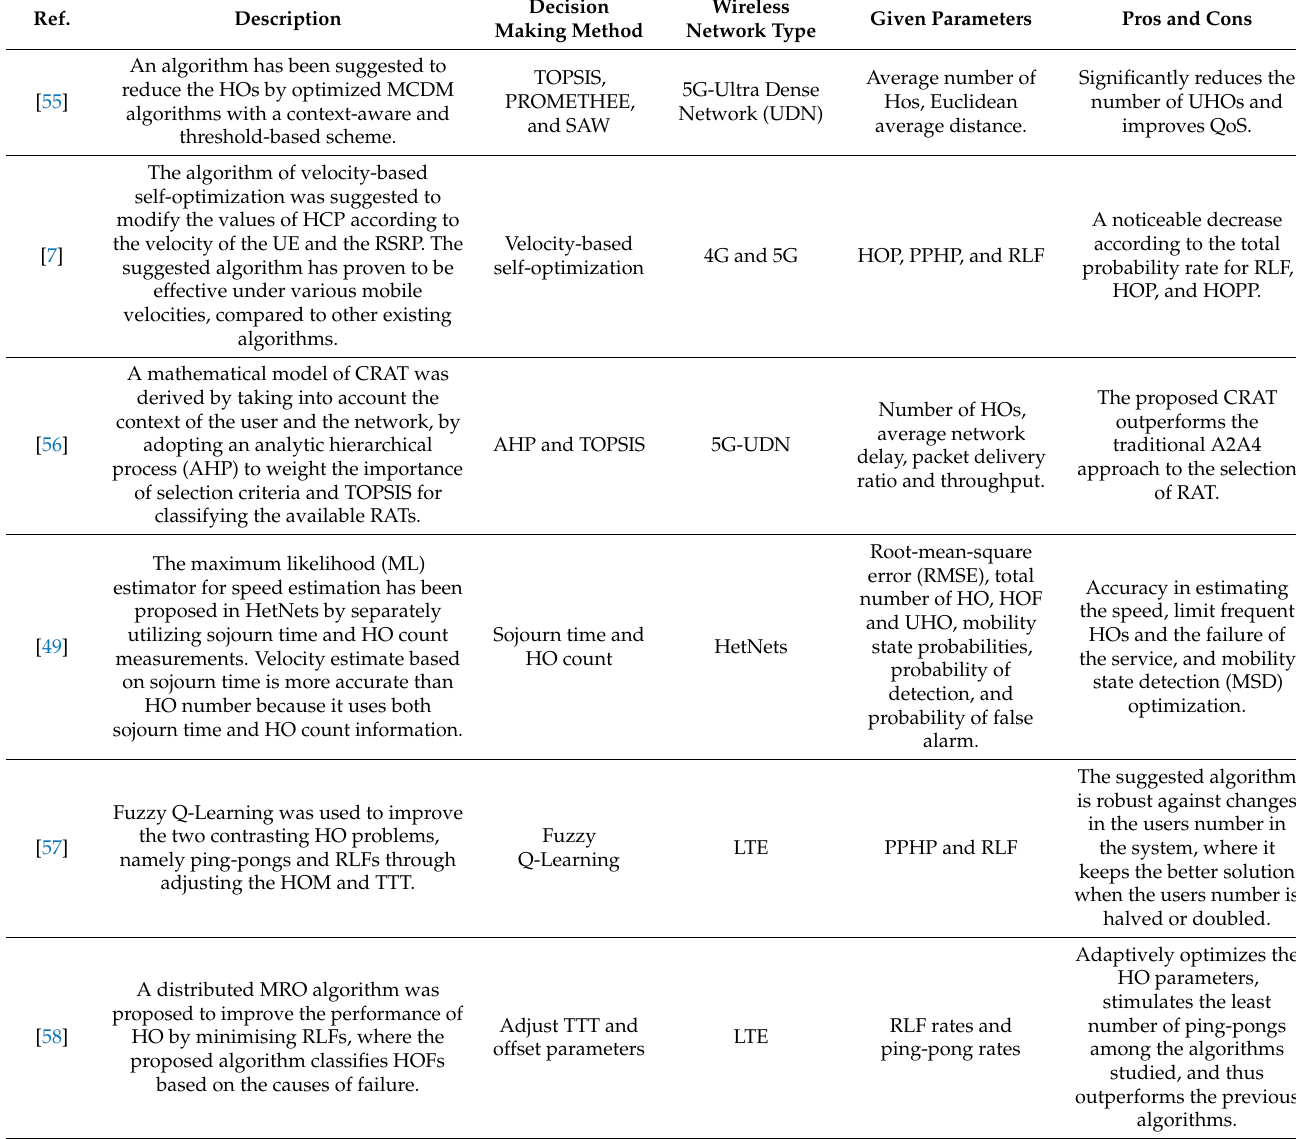
Table 1. Summary of the HO optimisation